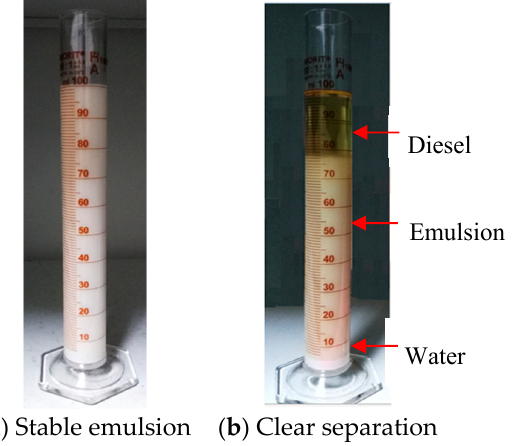
Figure 1. Picture of water-in-diesel emulsion at 10% water content showing the emulsions before separation ( a ) and with the layers of separation ( b ).